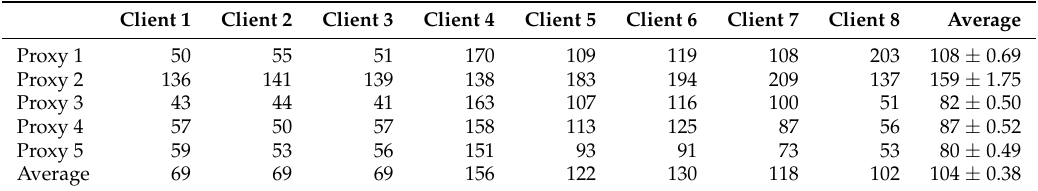
Table 5. Average MAE obtained by AMF for each client/proxy pair, with a 40% density. Values are in milliseconds.